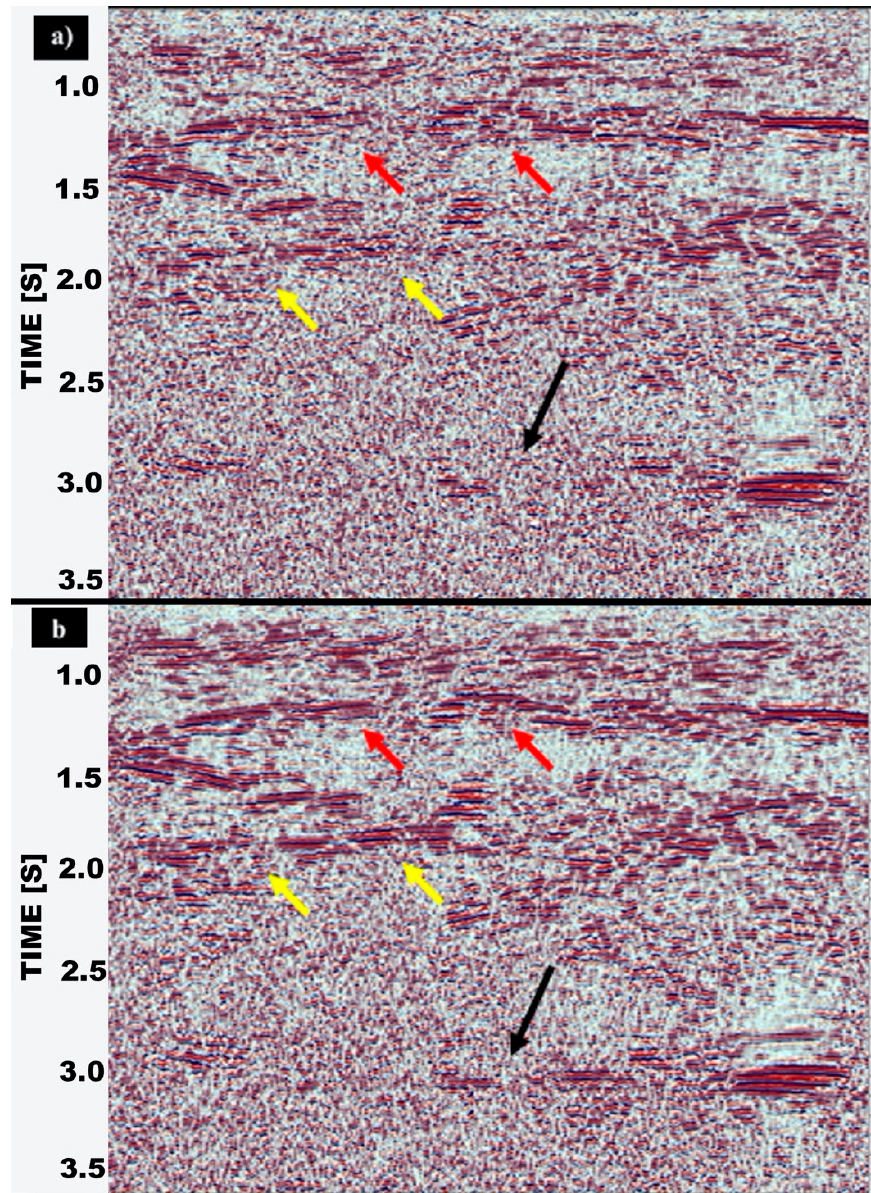
Figure 8. A comparison of the seismic section of Mesozoic sediments before ( a ) and after ( b ) filtering application.